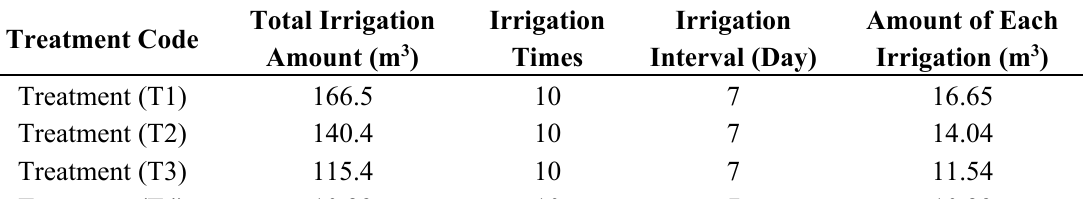
Table 1. Experiment treatments from 24 June to 30 August 2007.